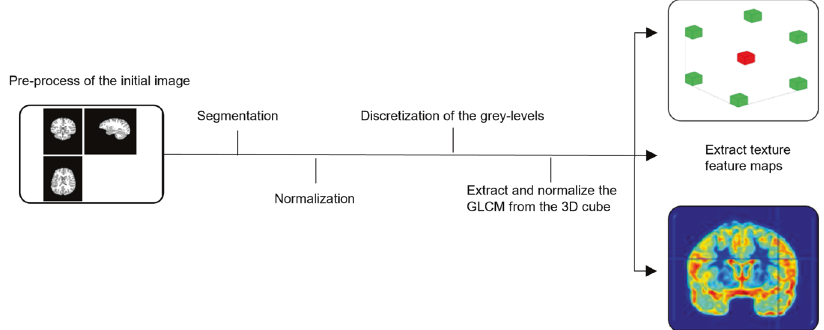
Fig. 2 Work fl ow chart. Work fl ow for the calculation of the texture feature